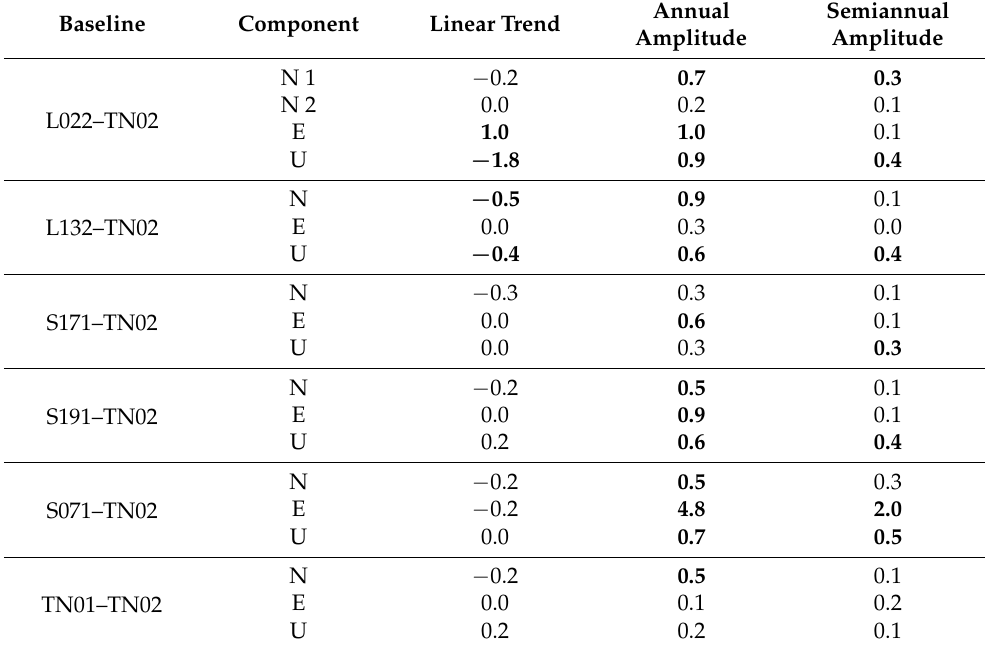
Table 3. Linear trend term (mm/yr) and annual and semiannual signal amplitude estimates (mm). Baseline Component Linear Trend